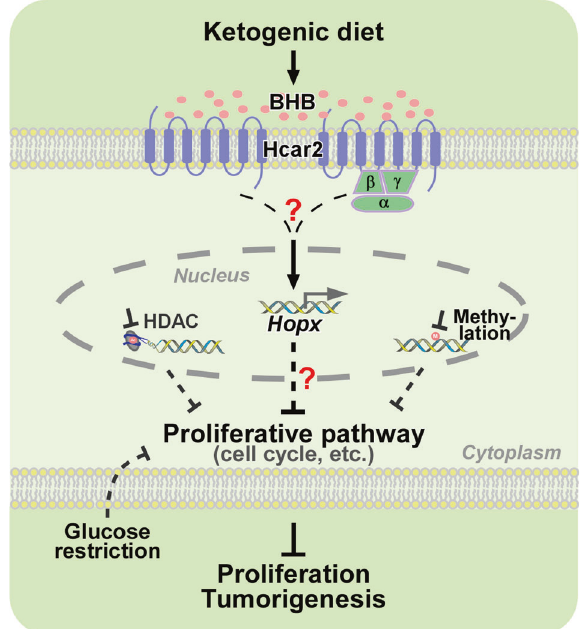
Fig. 1 Schematic illustration of the molecular mechanisms under- lying KD-mediated suppression in CRC growth. During a ketogenic diet, abundant ketone bodies, especially BHB, were produced in the liver and were transferred to colorectum via blood circulation. Once the concentration of BHB elevated around colorectal tumor cells, it binds to Hcar2, a G-protein-coupled receptors, and activation Hopx expression, thereby inhibiting cell proliferation and tumorigenesis through suppressing proliferative pathway, such as cell cycle. In addition, multiple combination treatment based on KD demon- strated additive effects on the suppression of CRC, such as the combination with glucose restriction, histone deacetylases inhibi- tors, and DNA methylation inhibitor. BHB: β -hydroxybutyrate; Hcar2: hydroxyl-carboxylic receptor 2; α , β , γ : G-protein subunits; Hopx: homeobox only protein homeobox; HDAC: histone